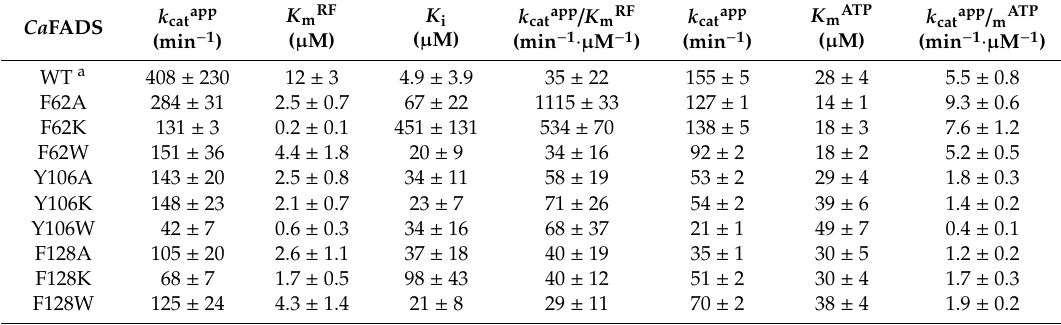
Table 2. Steady-state kinetic parameters for the riboflavinkinase (RFK) activity of Ca FADS